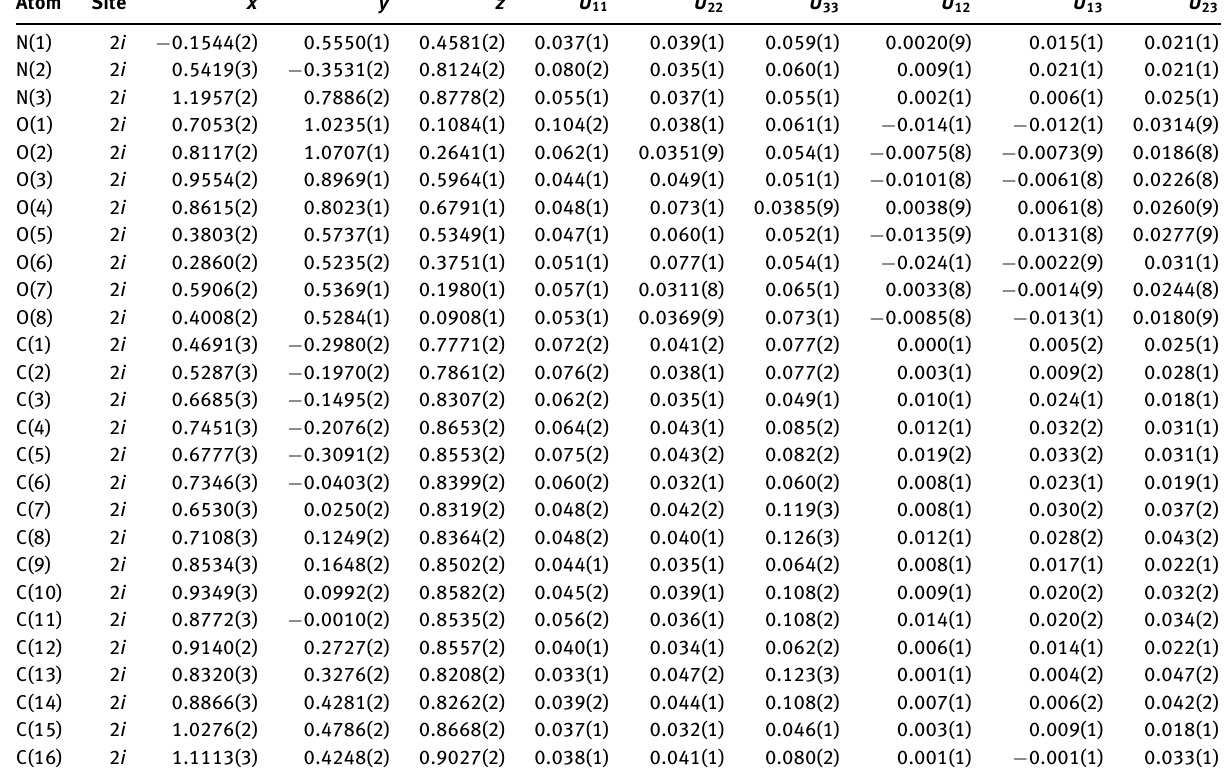
Table 3: Fractional coordinates and atomic displacement parameters (Å 2